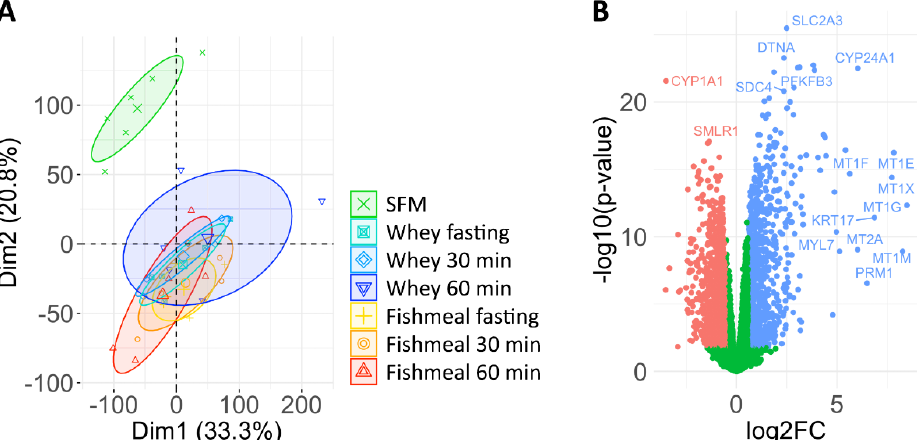
Figure 3. The gene expression profile of HepG2 cells incubated with or without human serum. ( A ) Principal component analysis of the gene expression (log 2 TPM) displaying the first two components. HepG2 cells were incubated with serum-free medium, medium supplemented with 20% human serum from fasting participants, or medium supplemented with serum taken 30 or 60 min after the intake of fishmeal or whey ( n = 5–6 per condition; Figure 1). ( B ) Differential gene expression analysis of cells incubated with serum from fasting participants versus cells cultured in serum-free medium. Genes that were >1.5-fold up- or downregulated (fdr < 0.05) are indicated in blue or red, respectively. SFM: serum-free medium. Table 4. The top-10 upregulated and downregulated genes.